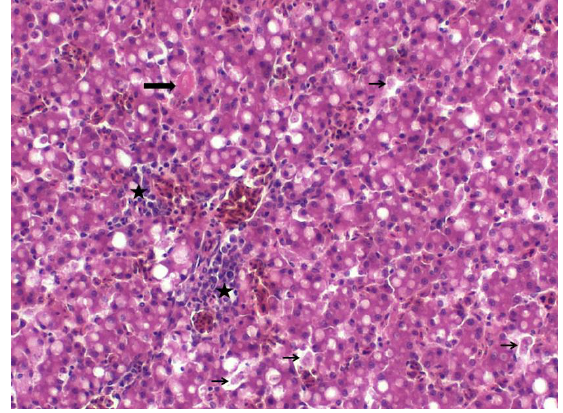
Figure 1. Liver, H&E stain, 200× magnification. Hepatitis with mild degeneration and vacuolation of hepatocytes, heterophilic to mixed inflammatory cell infiltration (stars), small deposits of fibrin (thick arrow), and individual cell necrosis (thin arrows).